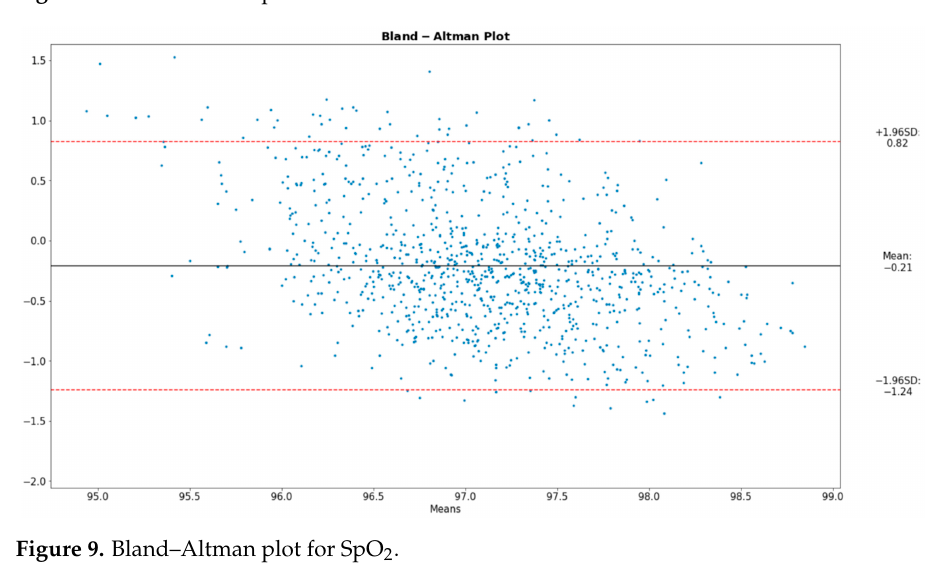
Figure 8. Bland–Altman plot for HR.